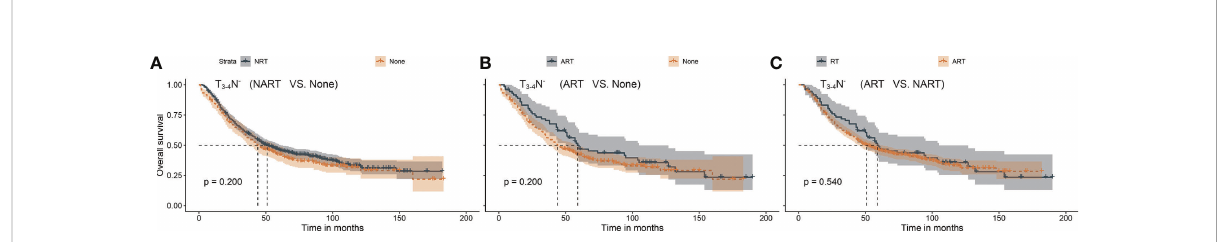
FIGURE 3 (A – C) Survival bene fi t after NART or ART in patients with T 3 – 4 N − . Patients with T 3 – 4 N − had no survival advantage after any ART or NART. NART, neoadjuvant radiotherapy; ART, adjuvant radiotherapy.